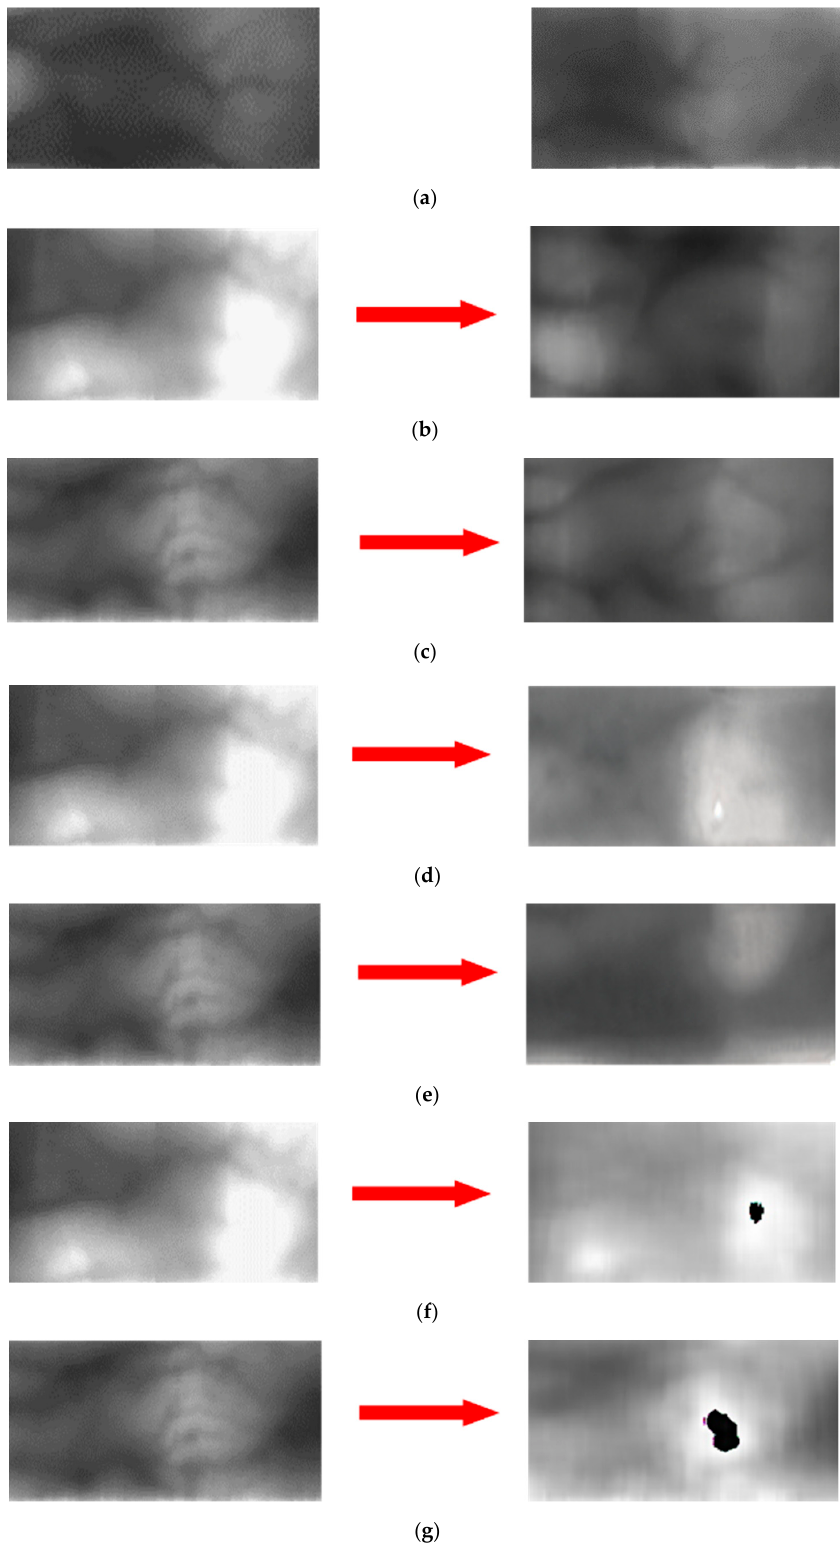
Figure 11. Examples of original images and domain adapted images: ( a ) Original image of SDUMLA-HMT-DB. Left and right images of ( b – g ), respectively, show original images and domain adapted images from HKPolyU-DB to SDUMLA-HMT-DB using various methods. ( b , c ) proposed method, ( d , e ) ComboGAN, ( f , g ) StarGAN-v2.